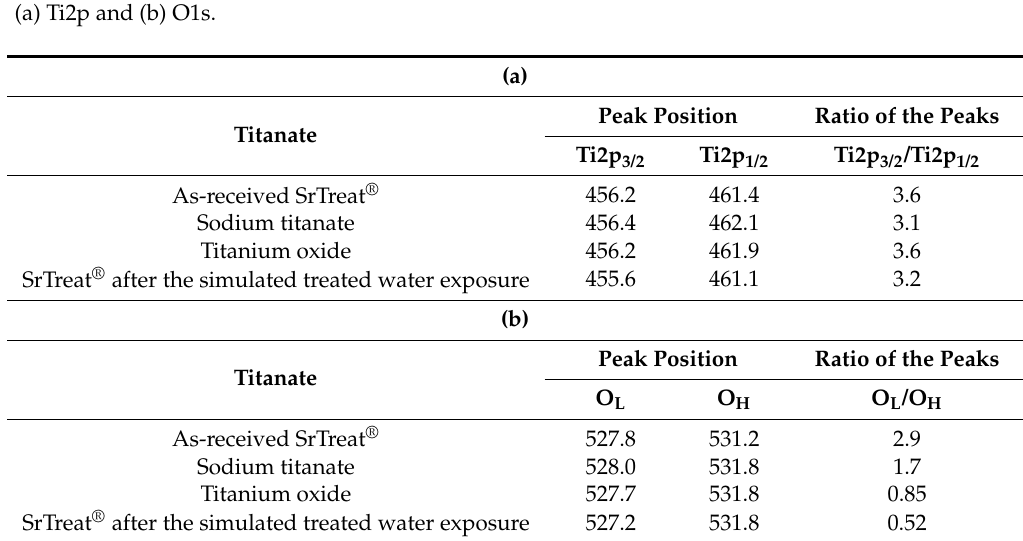
Figure 8. XPS spectra of the titanates investigated in the present study for bond energies corresponding to ( a ) Ti2p; ( b ) O1s; and ( c ) Na1s. Table 4. Peak intensity ratios of the titanates of the present study, determined by the XPS